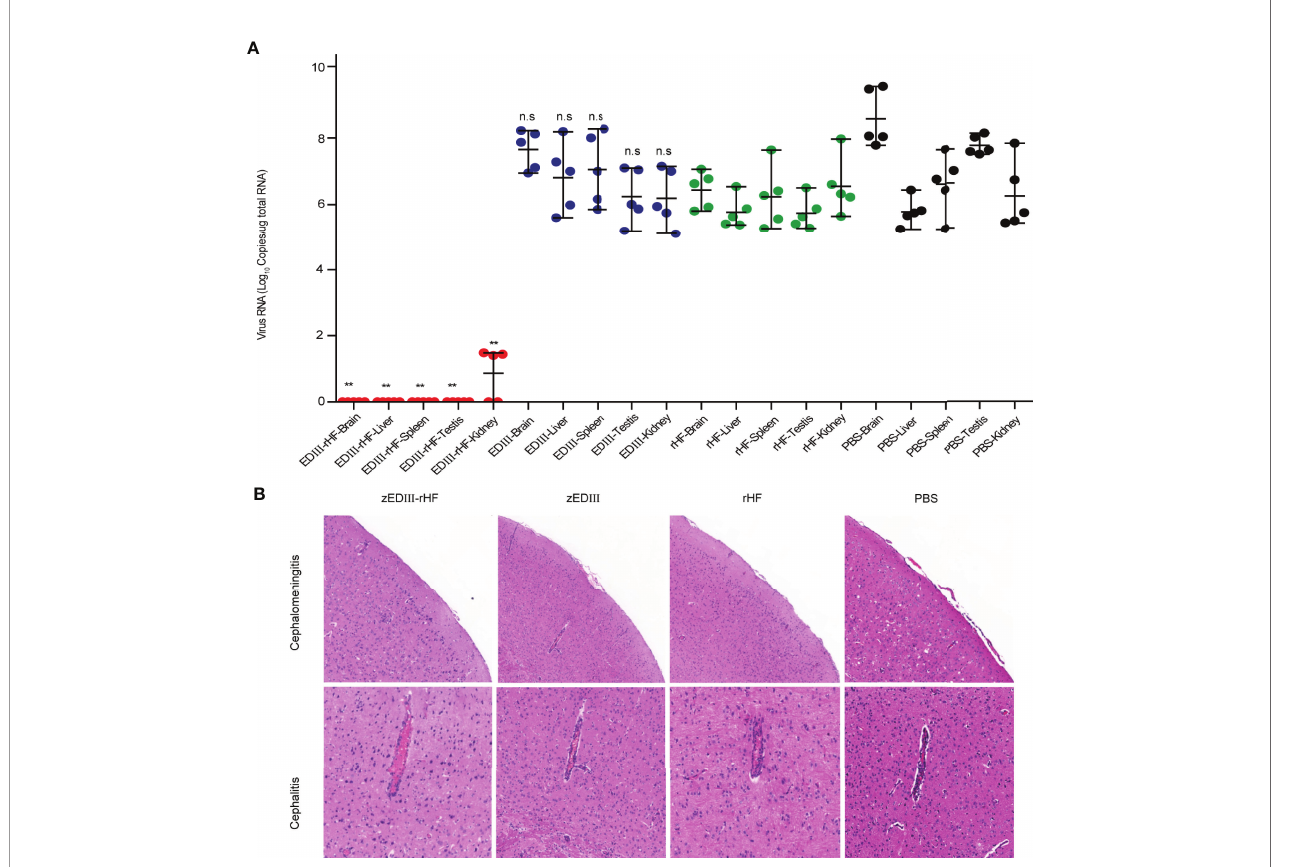
FIGURE 5 | Mouse tissues were obtained for ZIKV RNA measurement and histopathological analysis on day 7 postchallenge. (A) ZIKV RNA titers in the brain, liver, spleen, testis, and kidneys. (B) Histopathological analysis of brain tissue sections. The data in 5a are shown as the mean and standard deviation (mean ± SD) analyzed by Student ’ s t-test (two-tailed; *P < 0.05, **P < 0.01 compared with the PBS-treated group), n = 5. ns, no signi fi cant